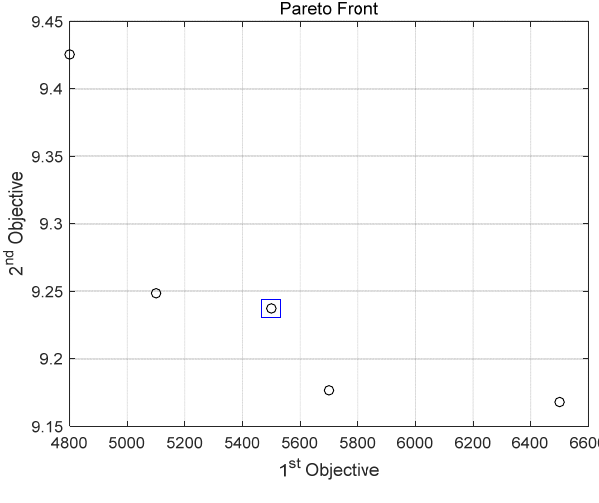
Figure 10. Pareto front.